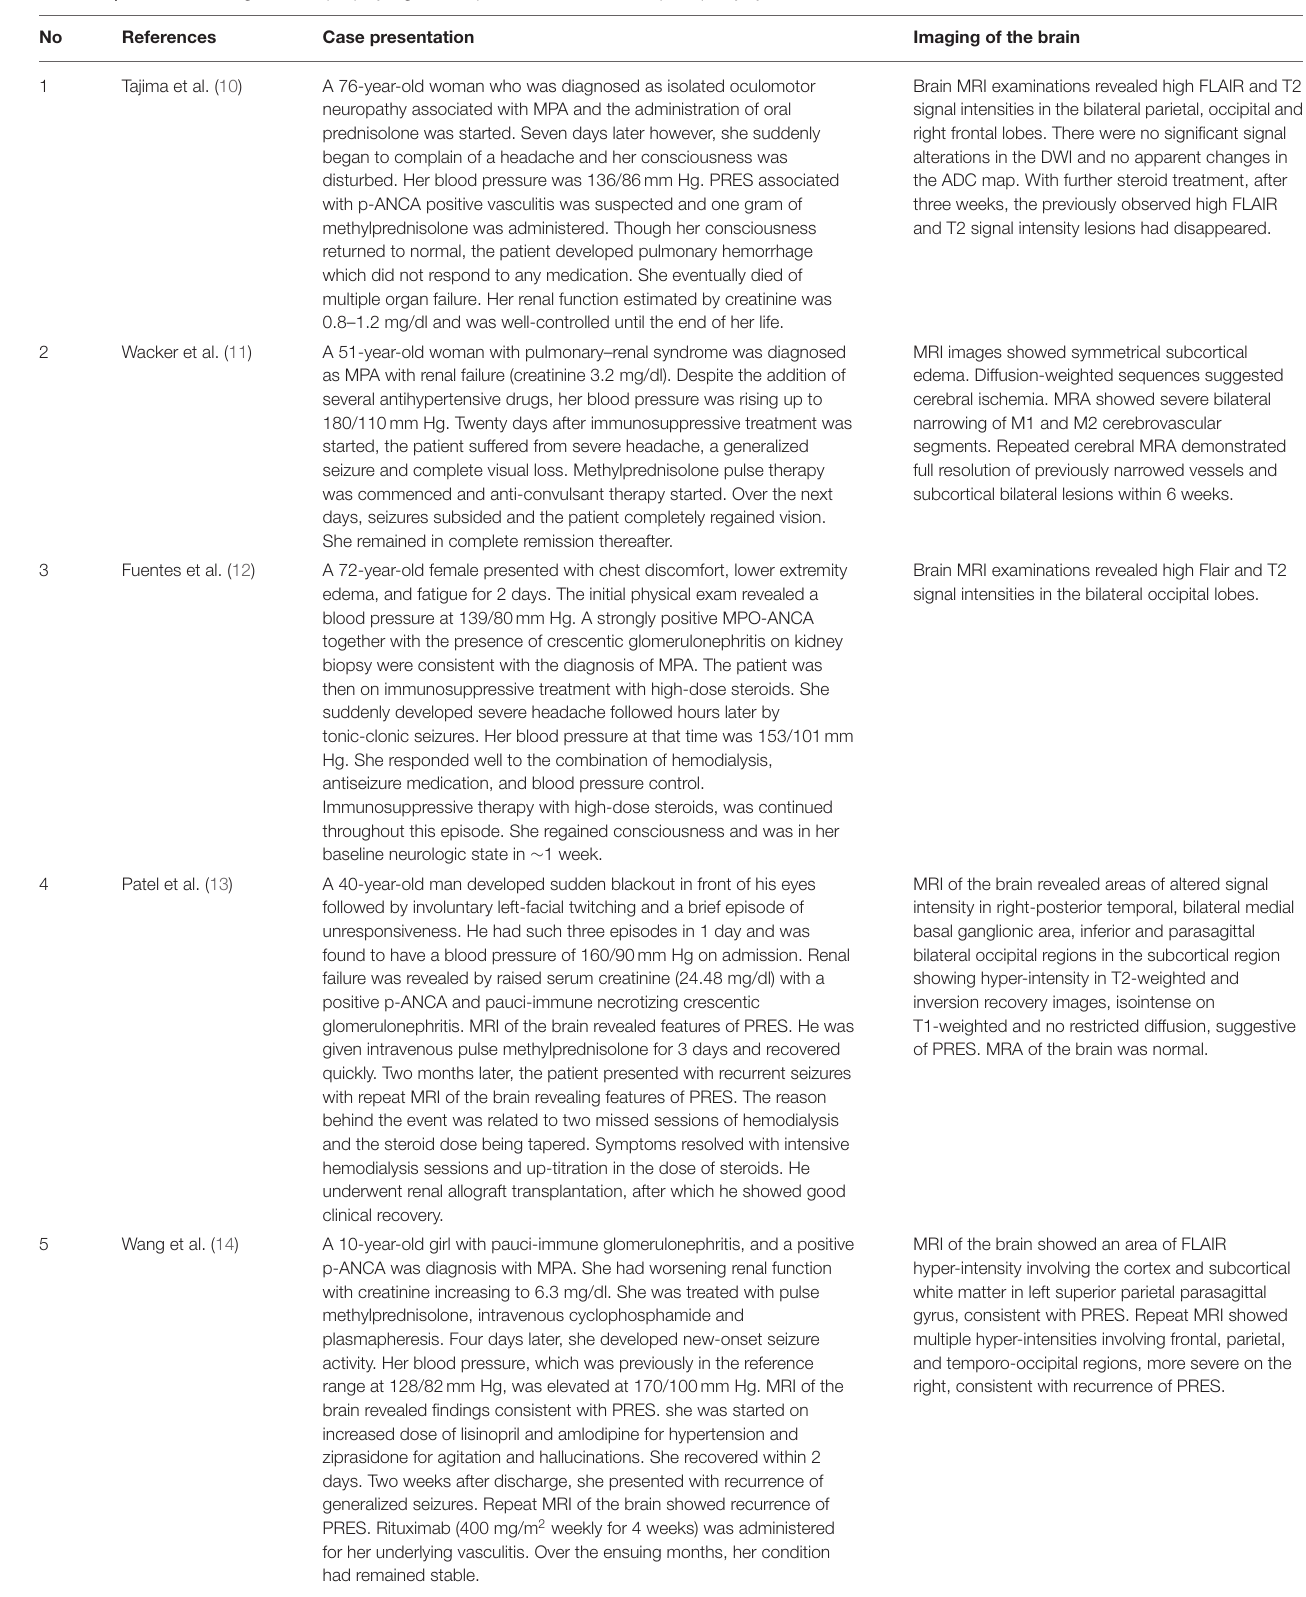
TABLE 1 | Cases describing microscopic polyangiitis with posterior reversible encephalopathy